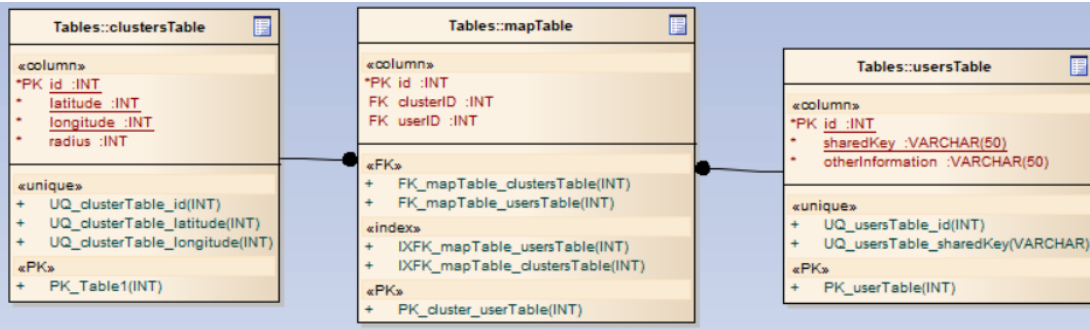
Figure 4. Database module-server application.